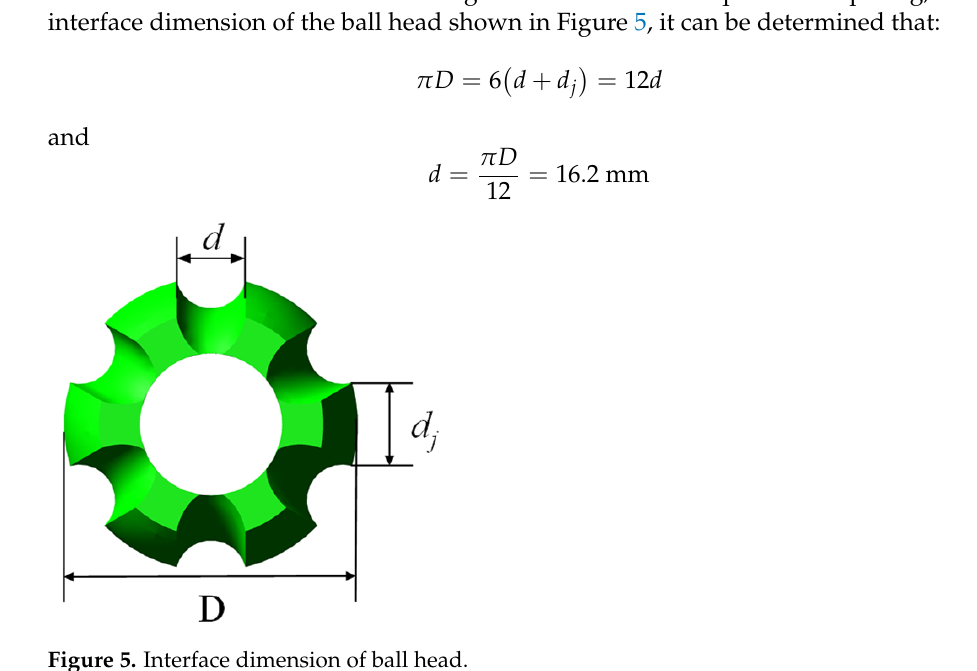
Figure 5. Interface dimension of ball head .